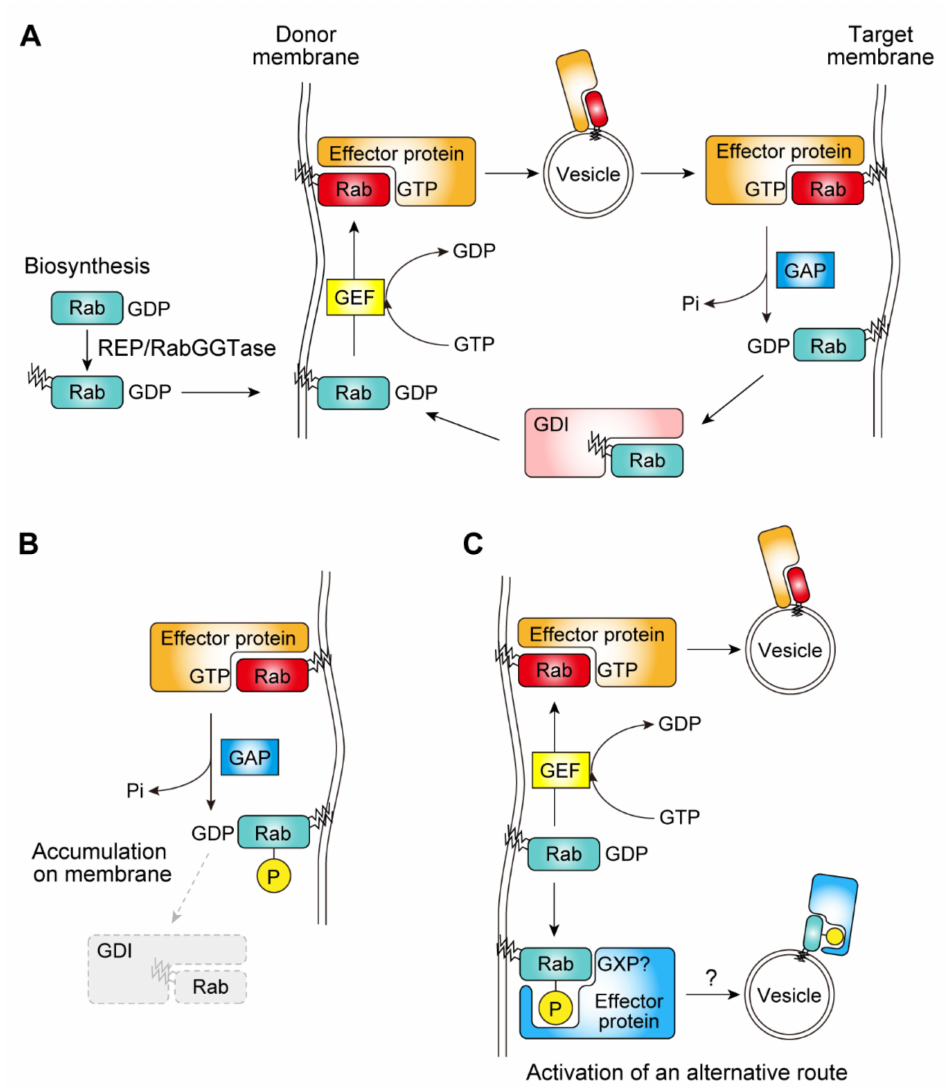
Figure 1. Schematic illustrations of the lifecycle of Rab proteins and proposed effects of phos- phorylation. ( A ) The general life cycle of Rab proteins. ( B ) A potentially inhibitory effect of Rab phosphorylation on the extraction by GDP-dissociation inhibitors (GDIs). ( C ) An alternative route activated by Rab phosphorylation. REP: Rab escort protein; RabGGTase: Rab geranylgeranyl trans- ferase; GEF: guanine nucleotide exchange factor; GAP: GTPase-activating protein; Pi: inorganic phosphate; GXP: GTP or GDP. ‘P’ in a yellow circle and blank yellow circles mean